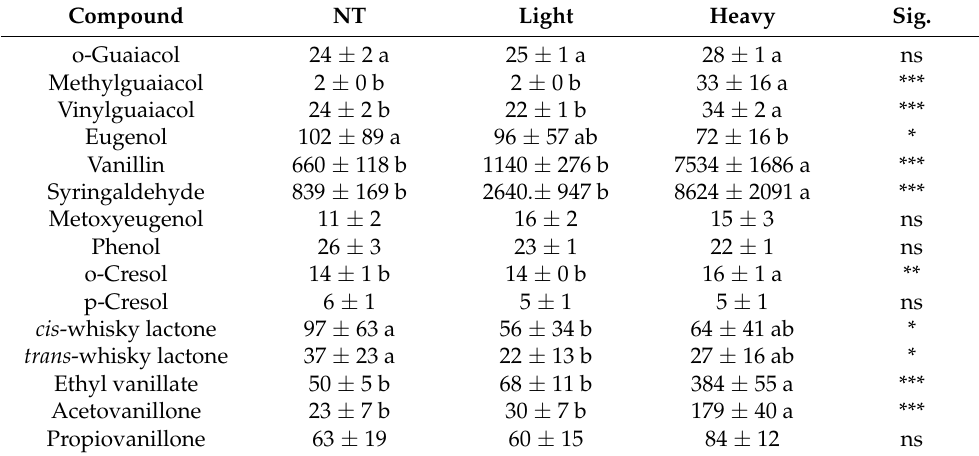
Table 6. The values represent the means measured for each toasting level ± standard error (SE). All data are expressed in µ g/L except where expressly indicated. Different letters within each row denote significant difference between the wines at p < 0.05 (Tukey’s post hoc test). *, **, *** and ns: differences significant at p < 0.05, 0.01, 0.001 and not significant, respectively. The results refer only to the test samples treated with oak